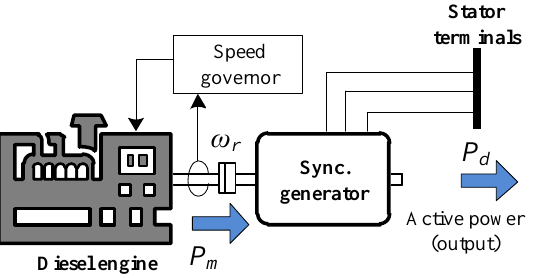
Figure 3. Schematic representation of the thermal generation under study.